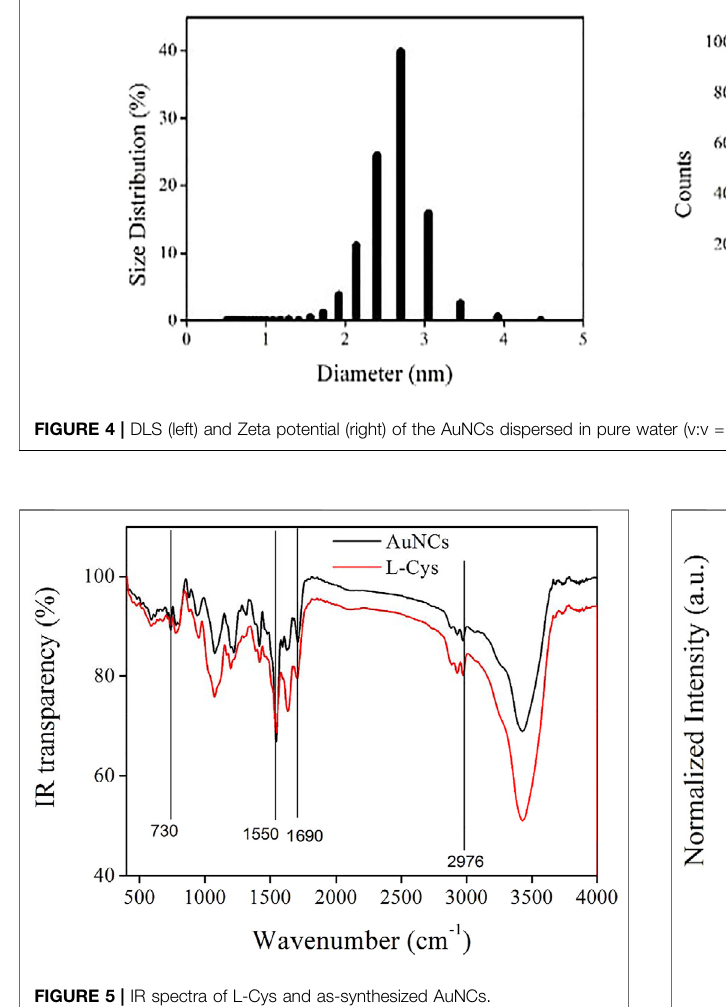
FIGURE 6 | Absorption, excitation, and emission of the AuNCs diluted by pure water (v:v (cid:1)